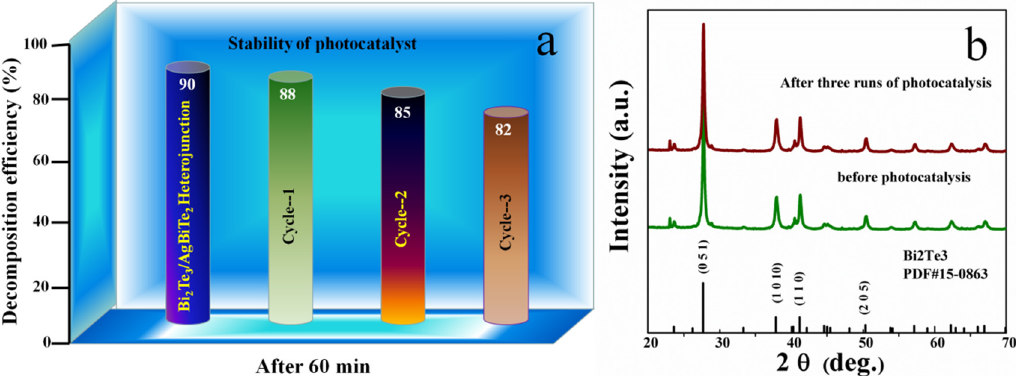
Figure 7. ( a ) Decomposition efficiency of Bi 2 Te 3 /AgBiTe 2 heterojunction nanostructures with an increasing number of catalytic cycle, ( b ) XRD patterns of Bi 2 Te 3 /AgBiTe 2 heterojunction nanostructures before and after photocatalytic runs.